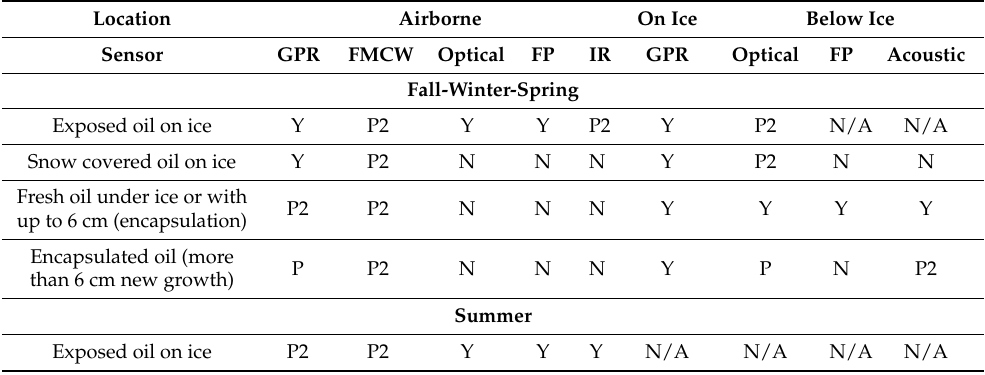
Table 5. Predicted operational characteristics of the devices used based on the results of laboratory studies and computer modeling [66].